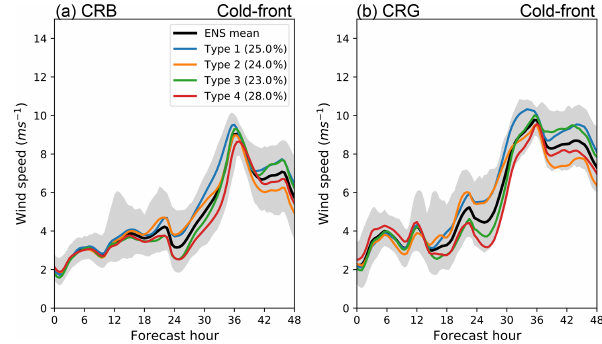
Figure 7. The same as Fig. 4 but for the cold-front